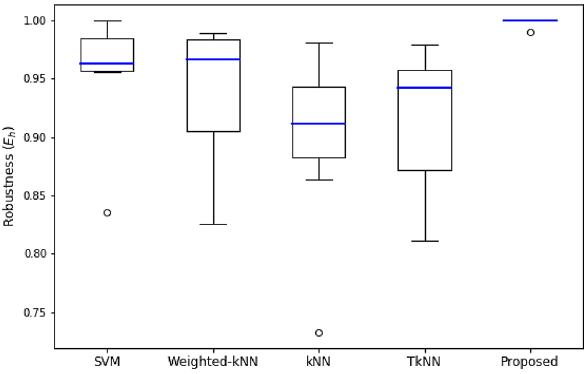
Fig. 2 Robustness of different classifiers using macro-averaged F